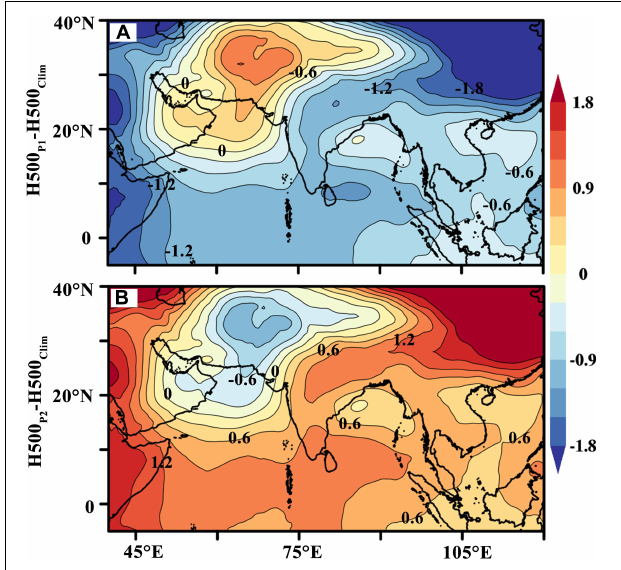
FIGURE 11 | The anomalous geopotential height at 500 hPa (Unit:gpm) in southwest monsoon season for the (A) P 1 (1985–1999) and (B) P 2 (2000–2015) periods from the climatology. The climatology of geopotential height at 500 hPa (H500 Clim ) is calculated for the 1985–2015